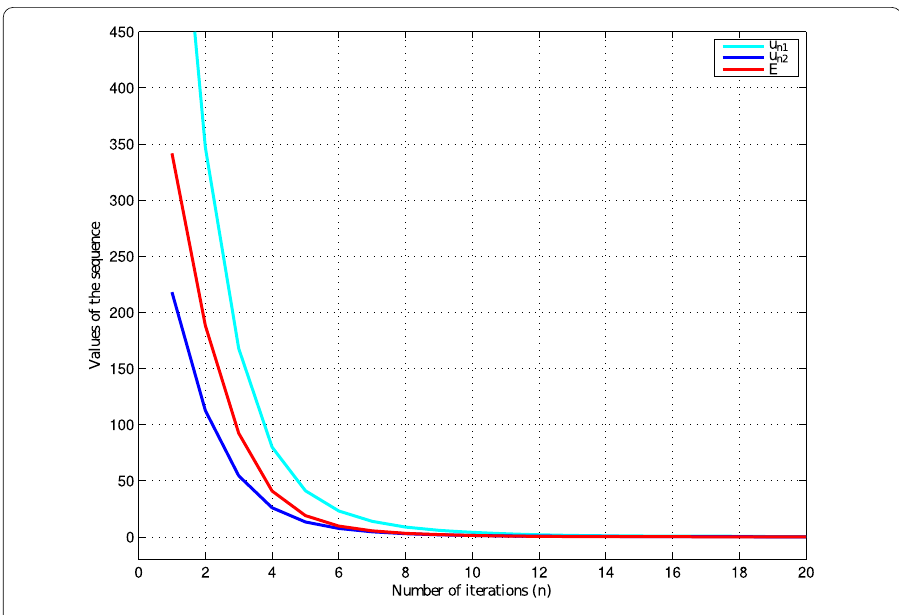
Figure 5 Convergence result of Theorem 3.11 with starting point of Case 1